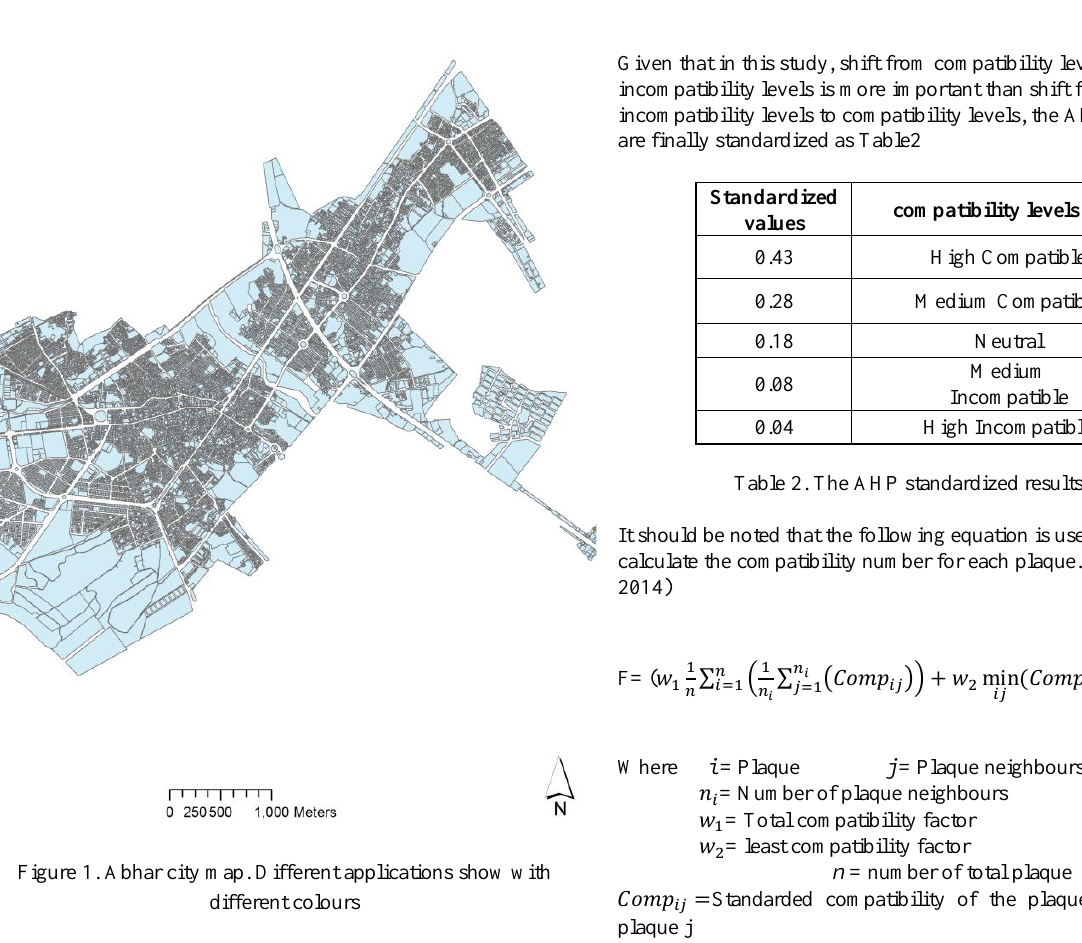
Figure 2. Center of Abhar, which there are different land-use